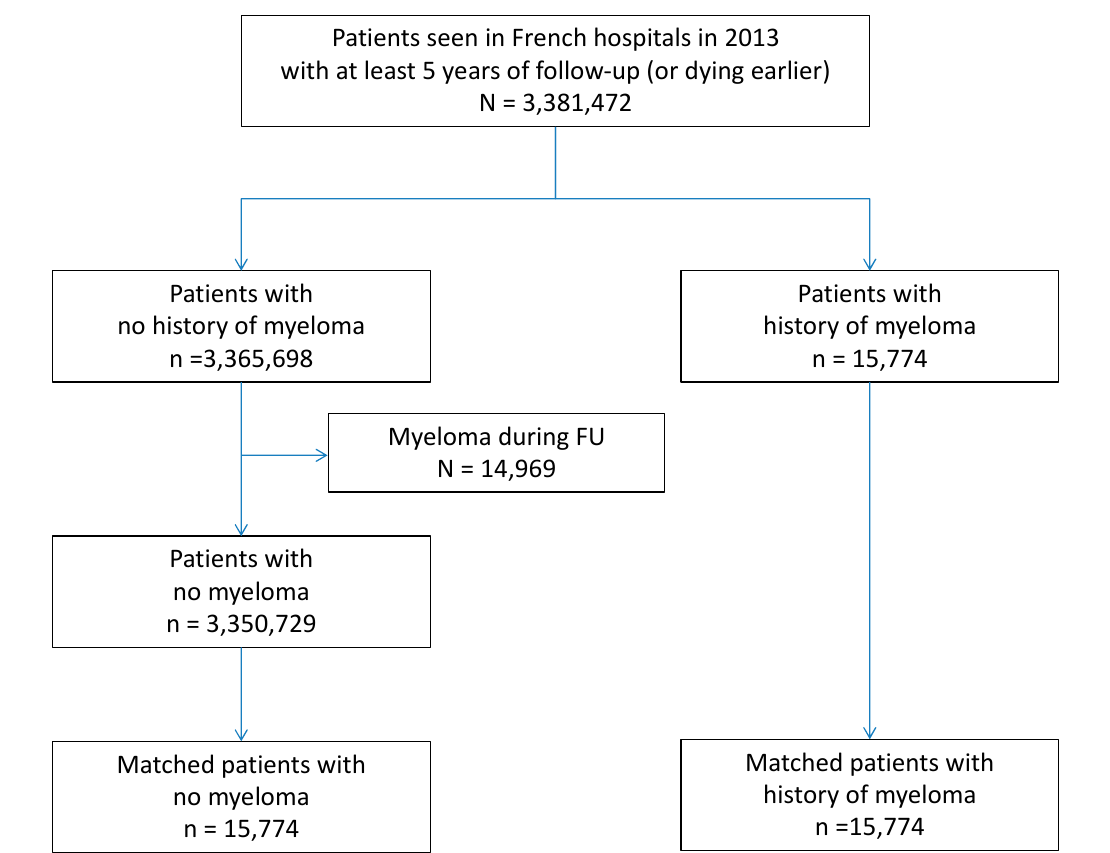
Figure 1. Flow chart of the study describing the incidences of major CV events in patients with or without a history of myeloma seen in French hospitals in 2013, with at least five years of follow-up. (FU = follow-up).